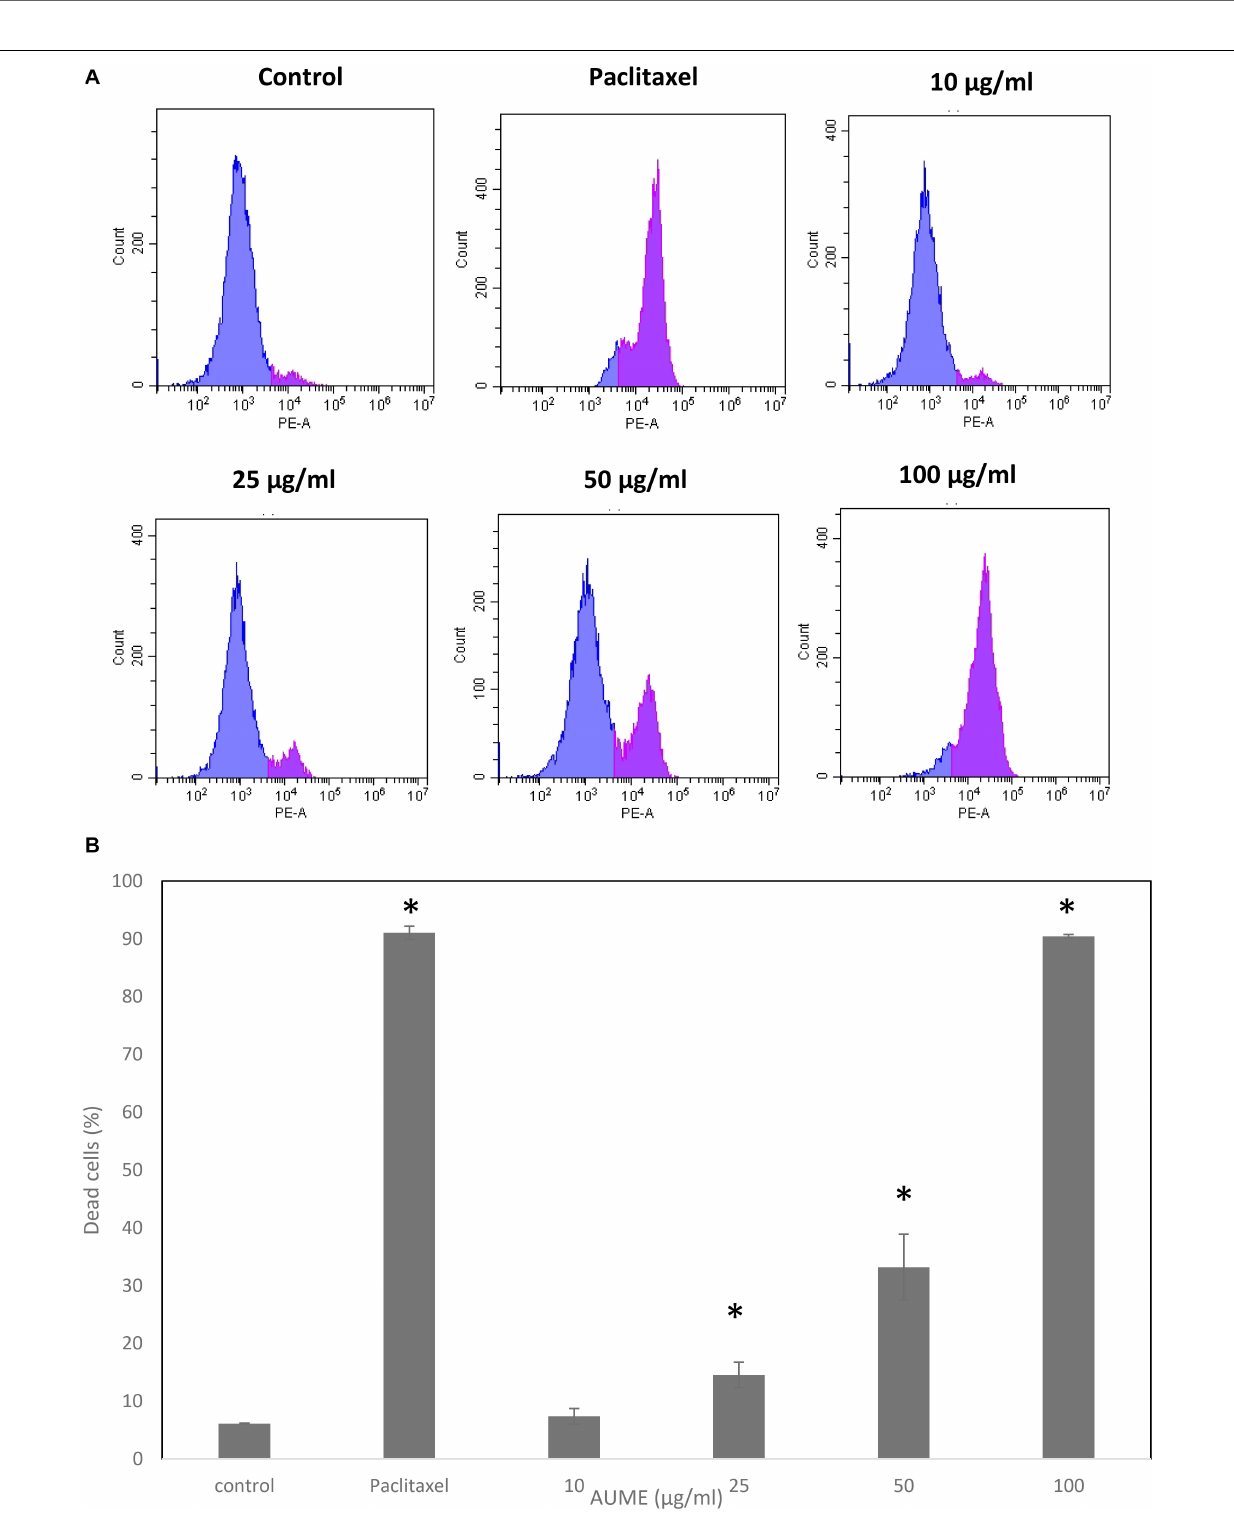
FIGURE 3 | (A) Cell viability studies of HeLa cells treated with indicated concentration of AUME estimated using PI staining followed by FACS analysis. (B) The bar diagram represents the percentage of dead cells in response to the AUME treatment. The data shown are average ± SD of values obtained from three replicates, p < 0.05, *statistically significant when compared to